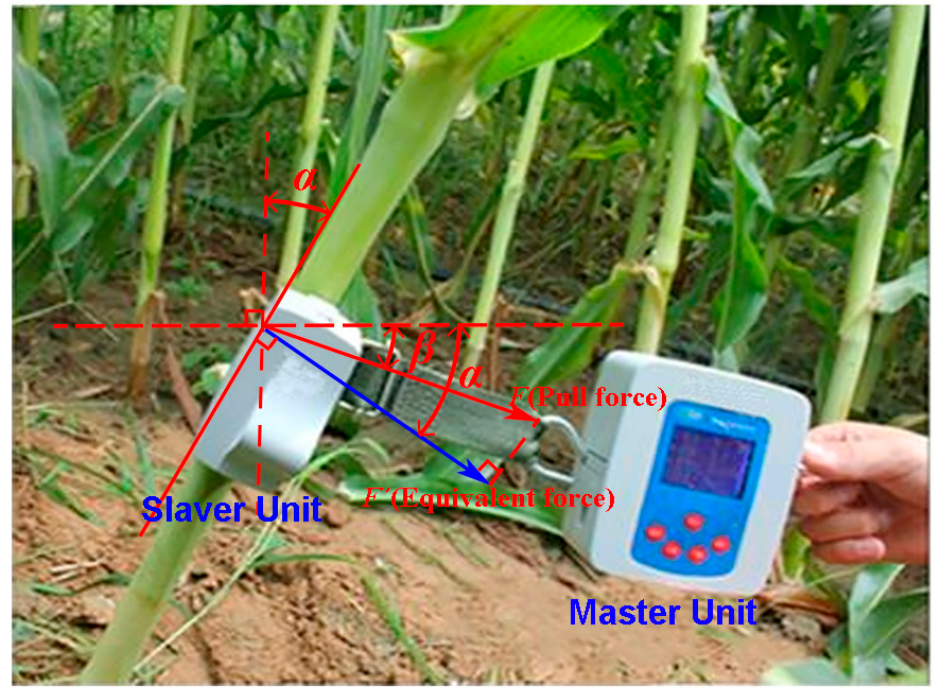
Figure 1. Schematic diagram for calculating the equivalent force under the pull force exerted upon the stalk.